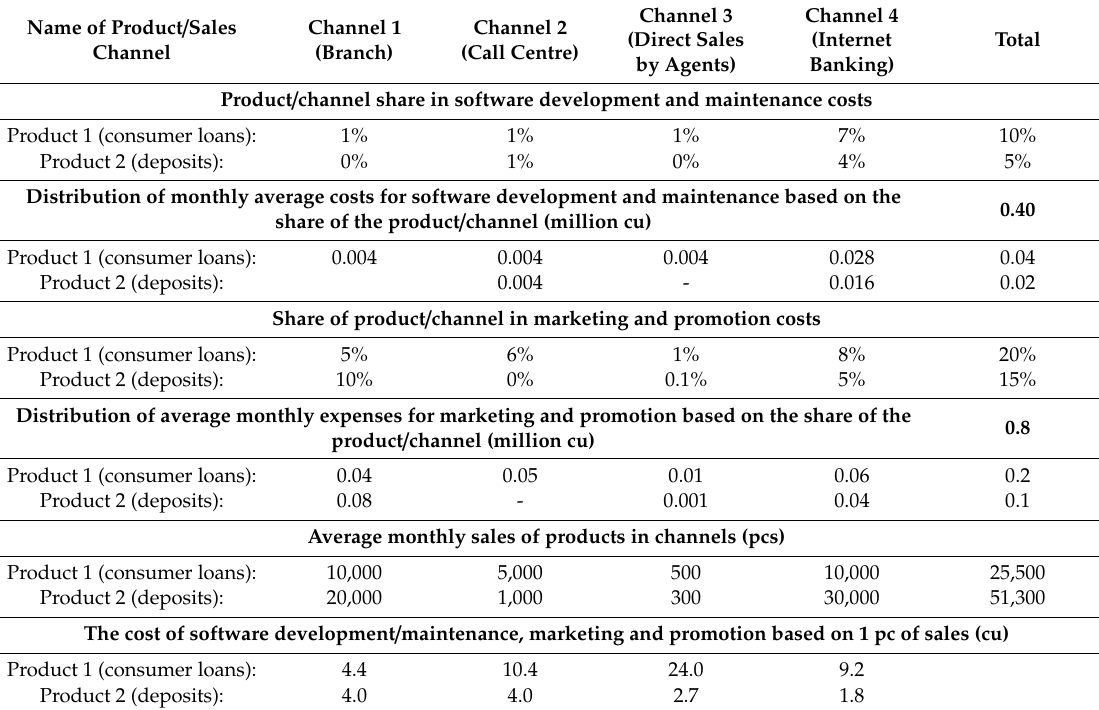
Table 3. Distribution to products and channels of software costs and